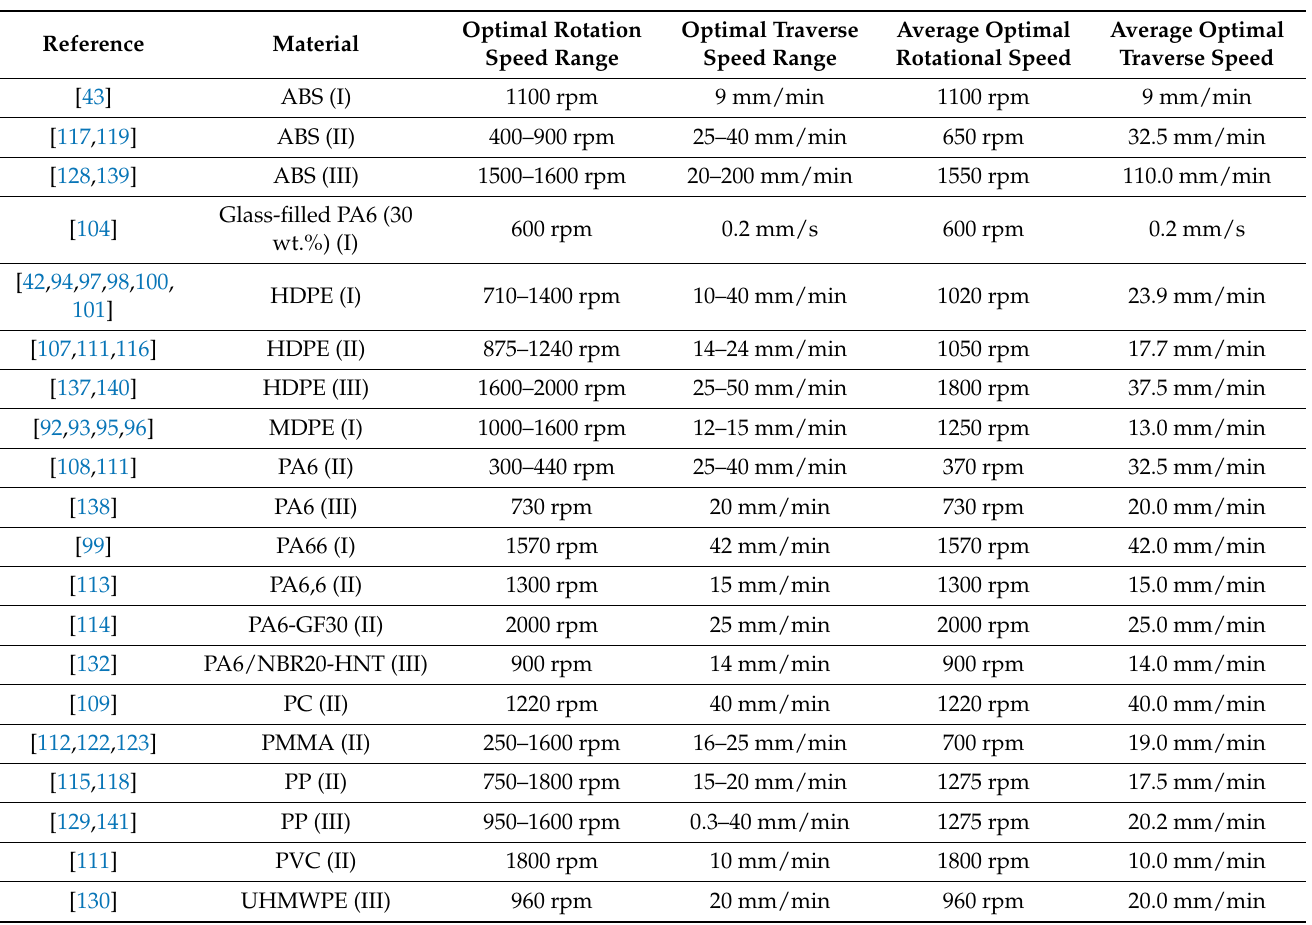
Table 5. Range and average of the optimal rotational and traverse speeds for thermoplastic polymer and polymer composite